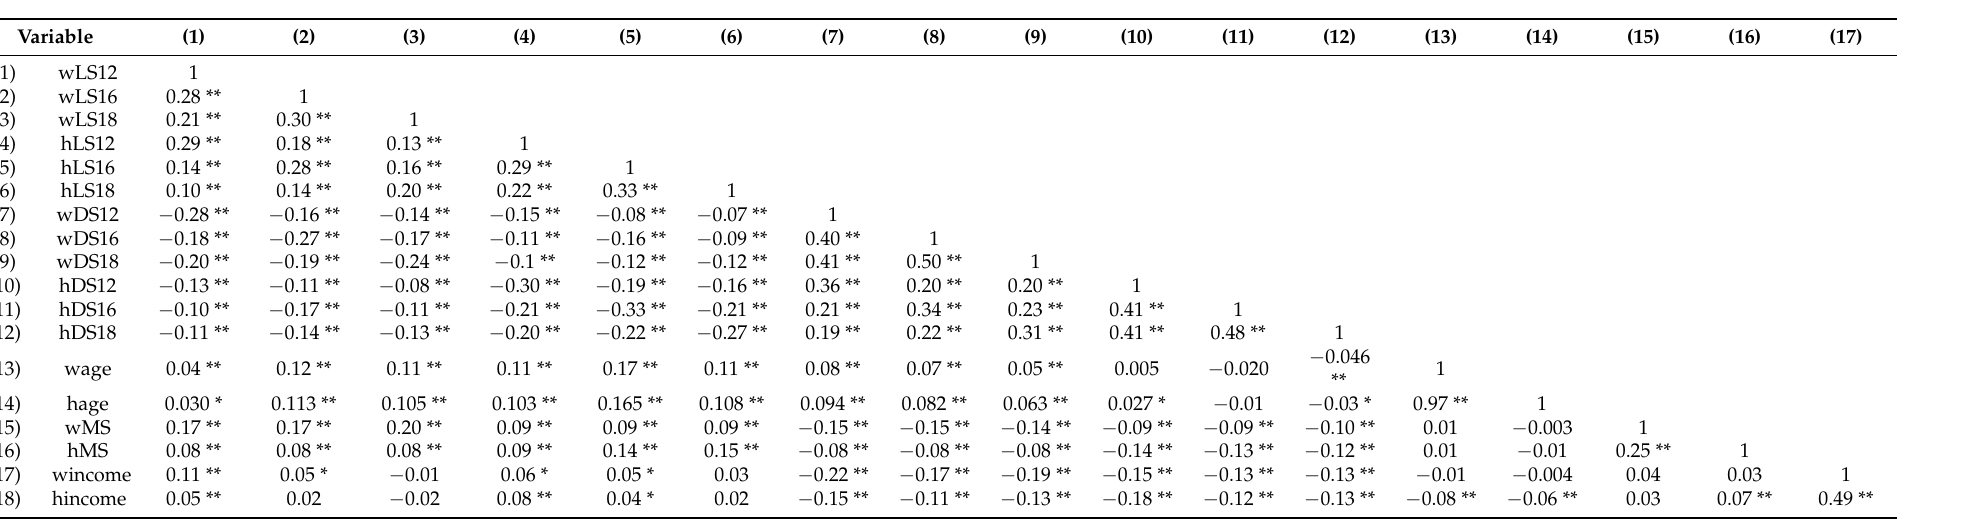
Table 2. Correlation coefficients between